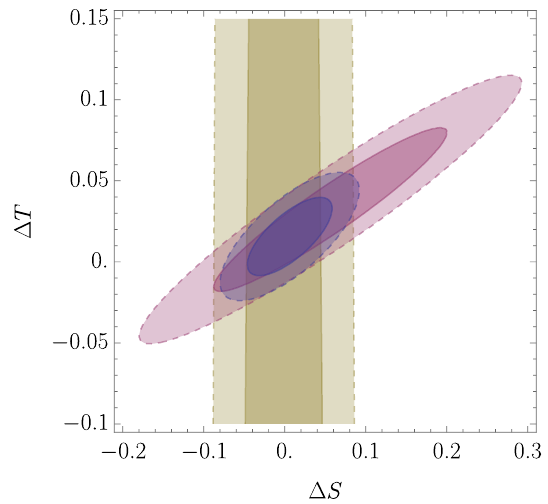
Figure 1. Fits to the (cid:1) S and (cid:1) T parameters [121{126] using Z -pole, W mass, and LEP 2 WW scattering measurements (red), using LHC Run 1 and Run 2 Higgs results (dark yellow), and all the data (blue). The darker and lighter shaded regions are allowed at 1 and 2 (cid:27) , respectively.